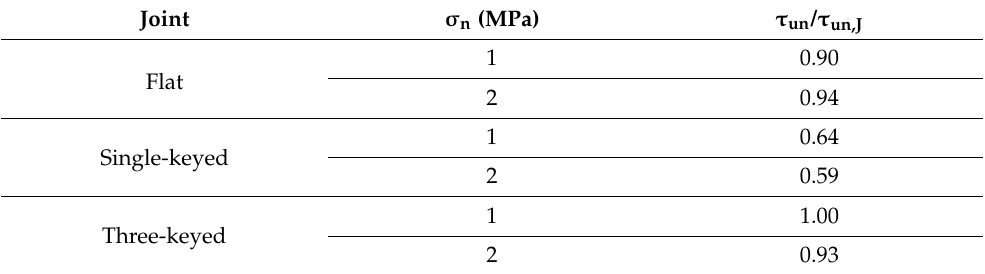
Table 9. Relationship between the experimental results of this research and those from Jiang et al. [30].